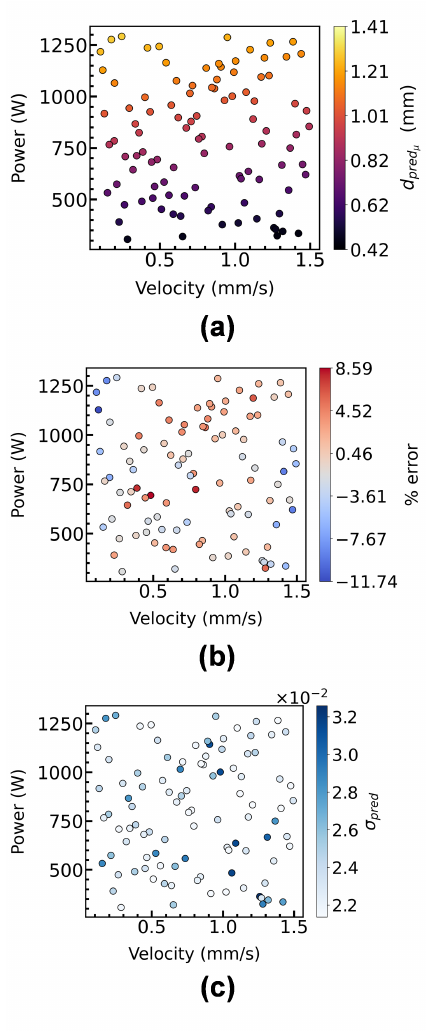
Figure 12. Comparison of ( a ) the mean predicted melt pool depth with ( b ) % error calculated as (cid:18) (cid:19) d pred µ − d true × 100%, and ( c ) standard deviation, σ d true with N H = 40 and N L = 80 on X test of 100 randomly sampled input data points from X Space